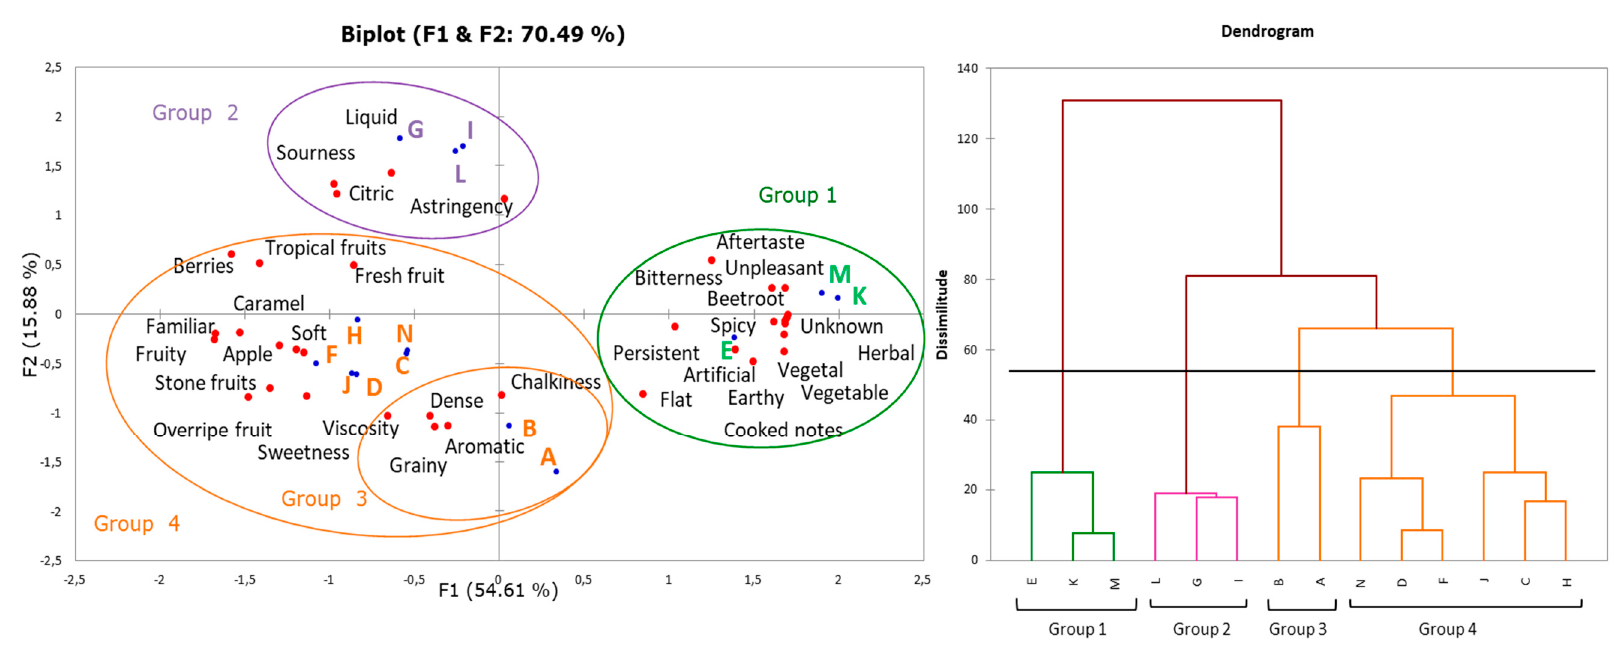
Figure 1. Multiple factor analysis biplot of terms used by a Spanish group of Millennial consumers for commercial smoothies in the Napping ® test and dendrogram using Pearson’s correlation based on the unweighted average.